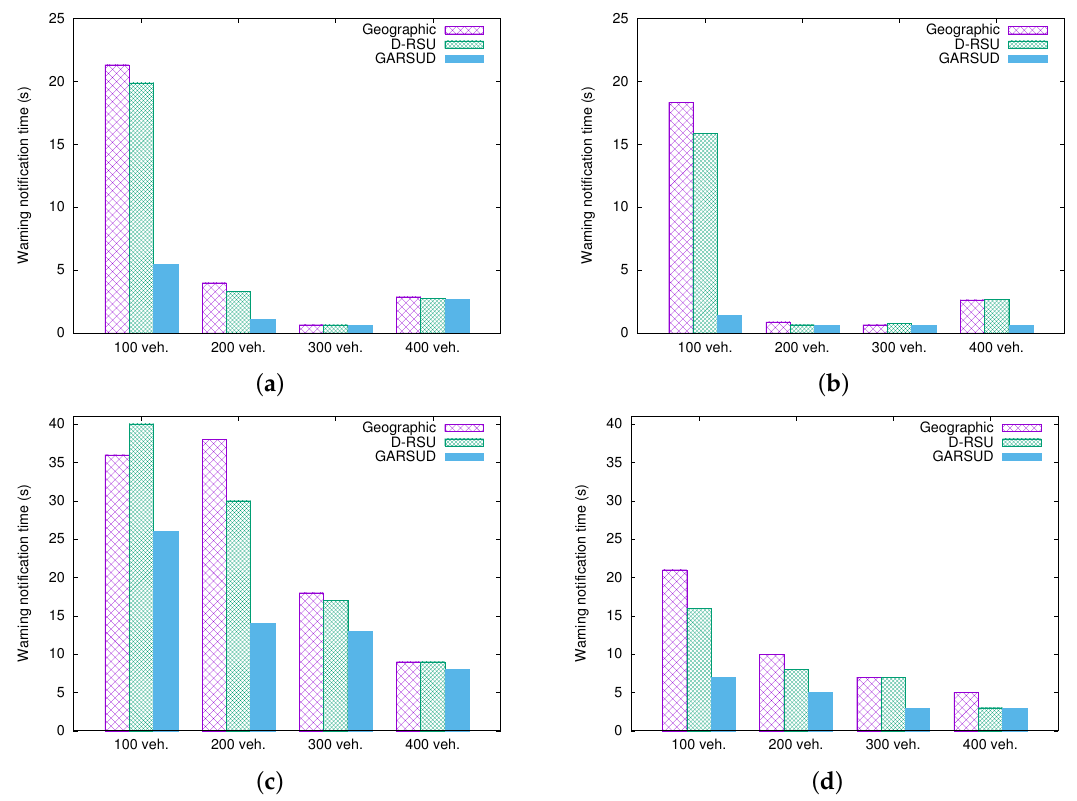
Figure 12. Warning notification time in Madrid and Valencia with a central downtown area when varying the density of vehicles. ( a ) Four RSUs: Madrid scenario; ( b ) 9 RSUs: Madrid scenario; ( c ) 4 RSUs: Valencia scenario; ( d ) 9 RSUs: Valencia